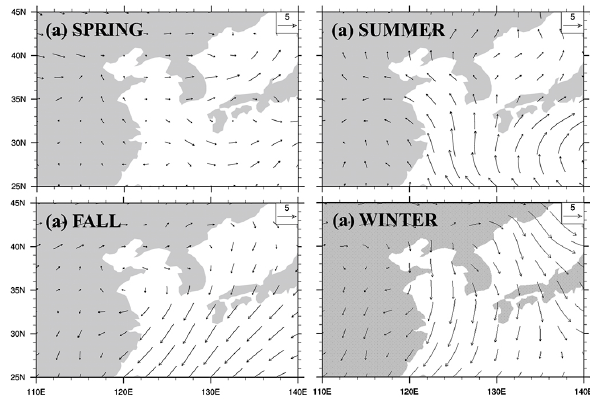
Fig. 7. Seasonally averaged surface wind vectors over East Asia: (a) spring, (b) summer, (c) fall, and (d) winter of 2006. The surface wind data were obtained from the NCEP/NCAR Reanalysis 1 data set and the predicted height corresponds to 0.995 of sigma.